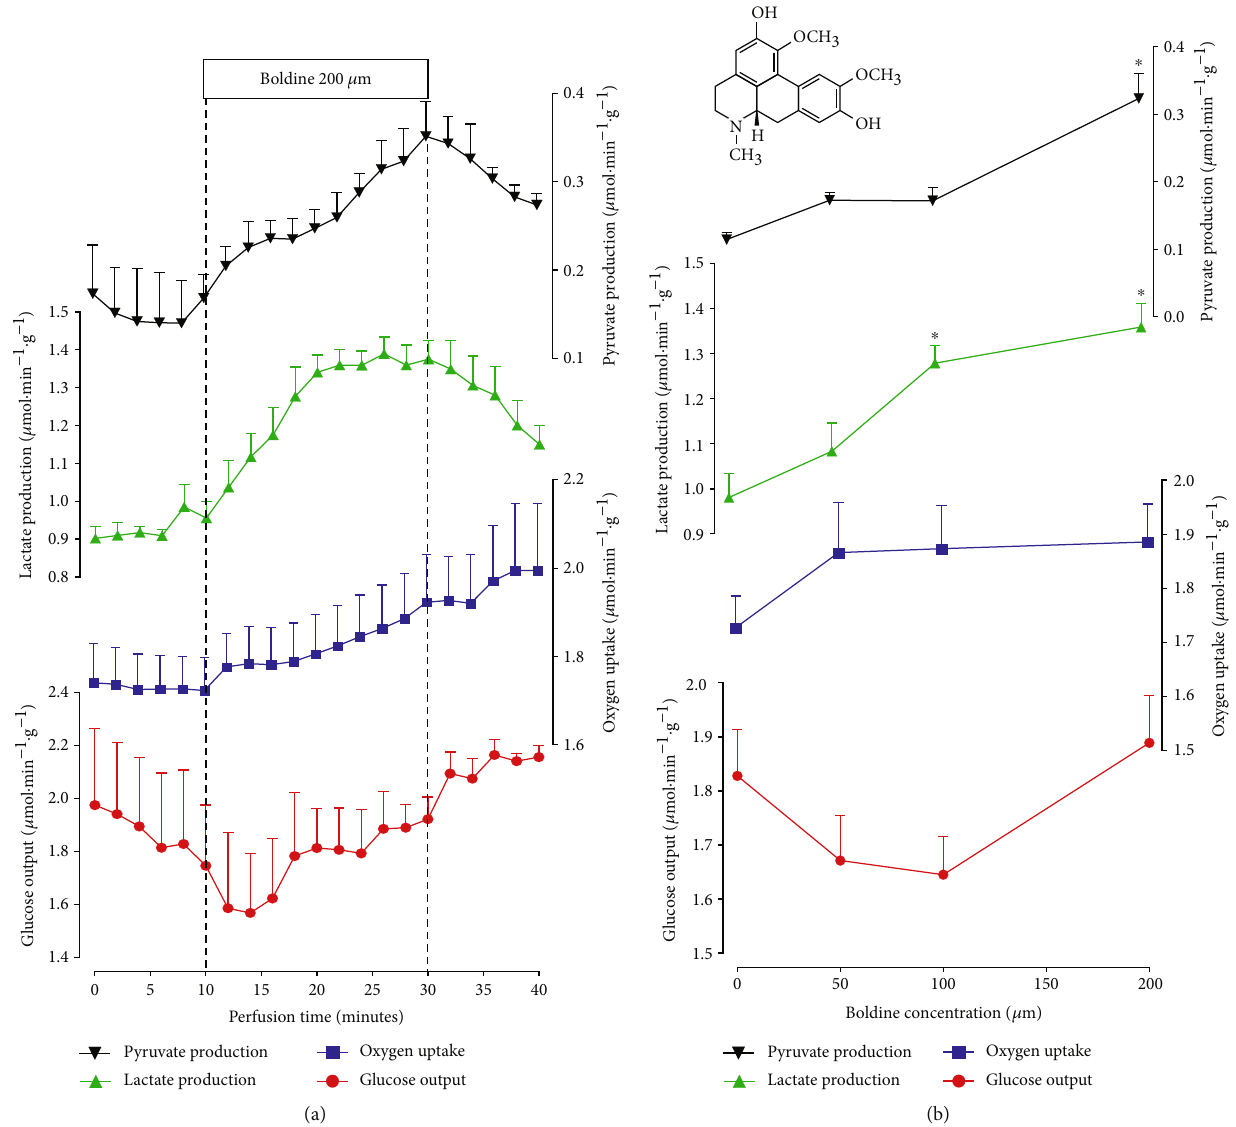
Figure 1: The e ff ects of boldine on glycogen catabolism in the livers from fed rats. (a) Time courses of the changes caused by 200 μ M boldine. Data are the means ± meanstandard errors of 4 to 6 liver perfusion experiments. The time period of boldine infusion is indicated by the horizontal bar. (b) Concentration dependences of the e ff ects of boldine on the rates of oxygen uptake, lactate and pyruvate productions, and glucose output. All parameters were evaluated before (10 minutes of perfusion time) and at 20 min after starting boldine infusion (30 minutes of perfusion time). The values corresponding to zero boldine concentration (controls) are the means ± mean standard errors of 12 perfusion experiments, computed just before initiating boldine infusion; rates in the presence of boldine represent the means of 4 liver perfusion experiments computed at 30 minutes of perfusion time. Asterisks ( ∗ ) identify those rates that di ff er from the control condition, as indicated by the post hoc Student-Newman-Keuls testing ( p ≤ 0 : 05